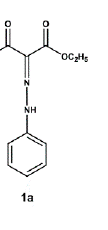
Figure 1. Structure of phenylhydrazinylidene derivatives 1a and 2 .